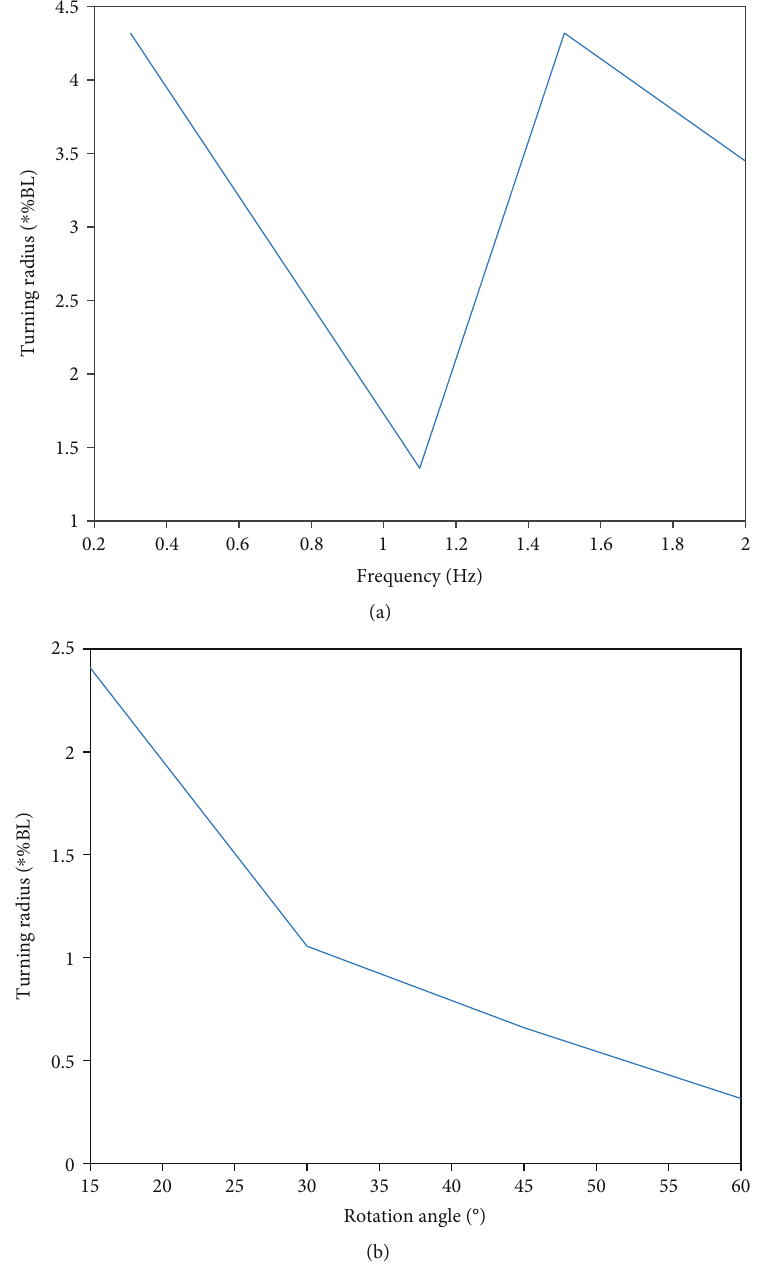
Figure 10: Optimization e ff ect on turning radius. (a) In fl uence of joint rotation frequency on turning radius. (b) In fl uence of joint rotation angle on turning radius.